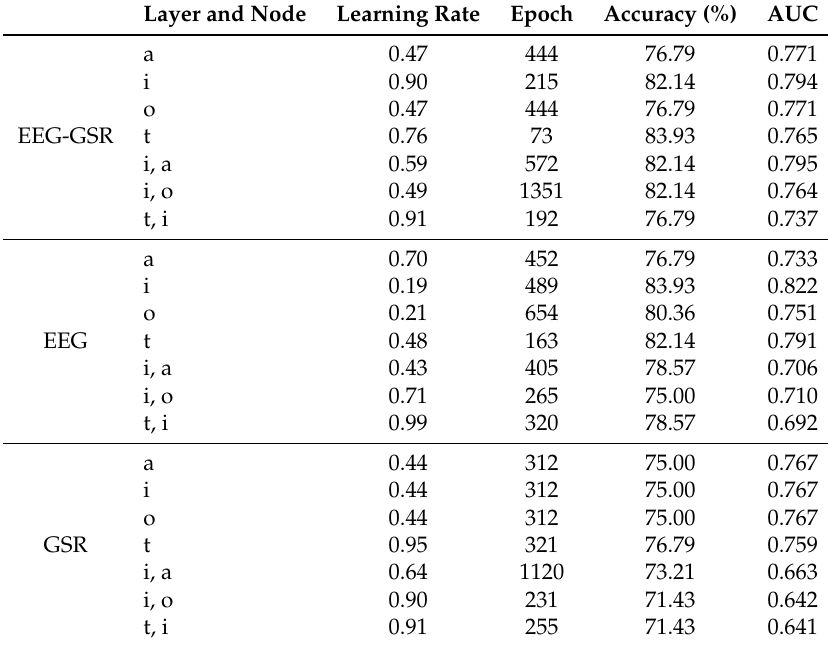
Table 6. MLP hyperparameter tuning